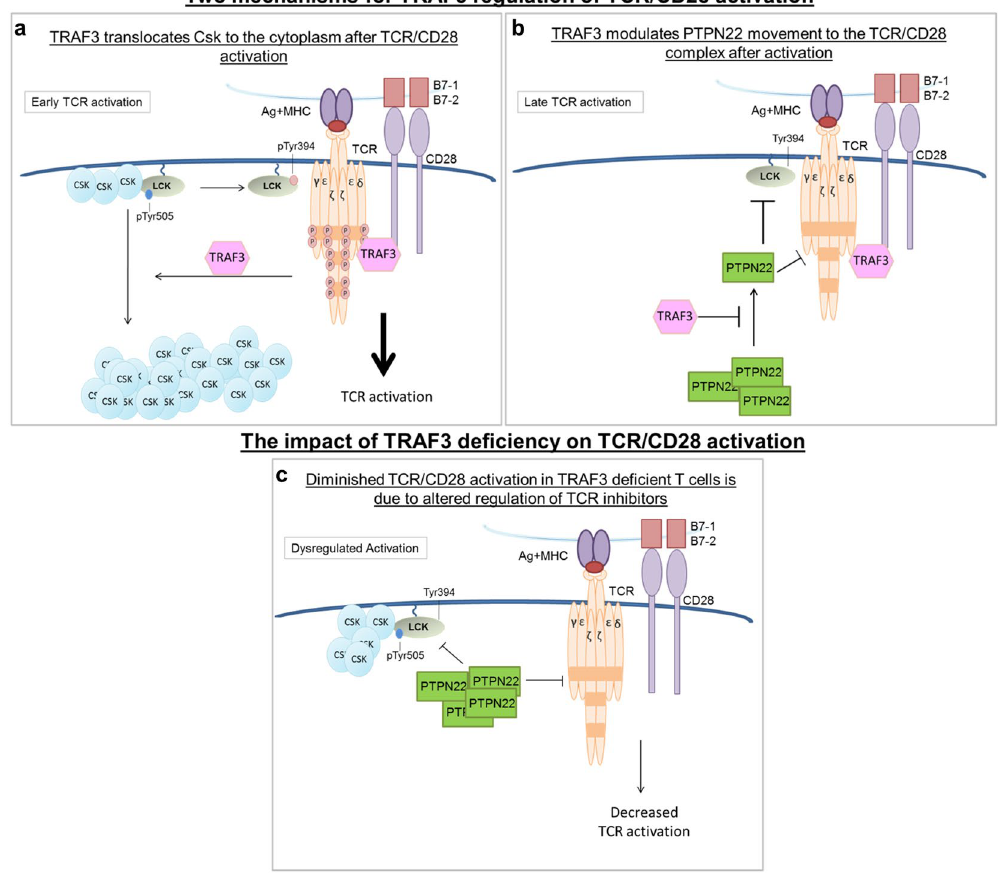
Figure 6. TRAF3 regulation of Csk and PTPN22 in TCR/CD28 signaling. TRAF3 regulates TCR signaling via at least 2 distinct mechanisms. During early TCR activation, TRAF3 associates with Csk to translocate Csk away from the plasma membrane to the cytoplasm ( a ). This allows the recruitment of activated Lck to the TCR complex where Lck phosphorylates the CD3 subunits. A second mechanism of TRAF3 regulation of TCR/CD28 signaling is by controlling the localization of cytosolic PTPN22 to the plasma membrane. To inhibit prolonged TCR/CD28 activation, TRAF3 regulates the amount and time at which PTPN22 is released to the membrane from the cytoplasm ( b ). Once at the membrane, PTPN22 dephosphorylates Lck and the CD3 subunits of the TCR complex to inhibit TCR/CD28 signaling. In the absence of TRAF3 both mechanisms of TCR/CD28 inhibition are enhanced. The loss of TRAF3 results in more Csk at the membrane and more PTPN22 recruited to the membrane earlier in TCR/CD28 activation ( c